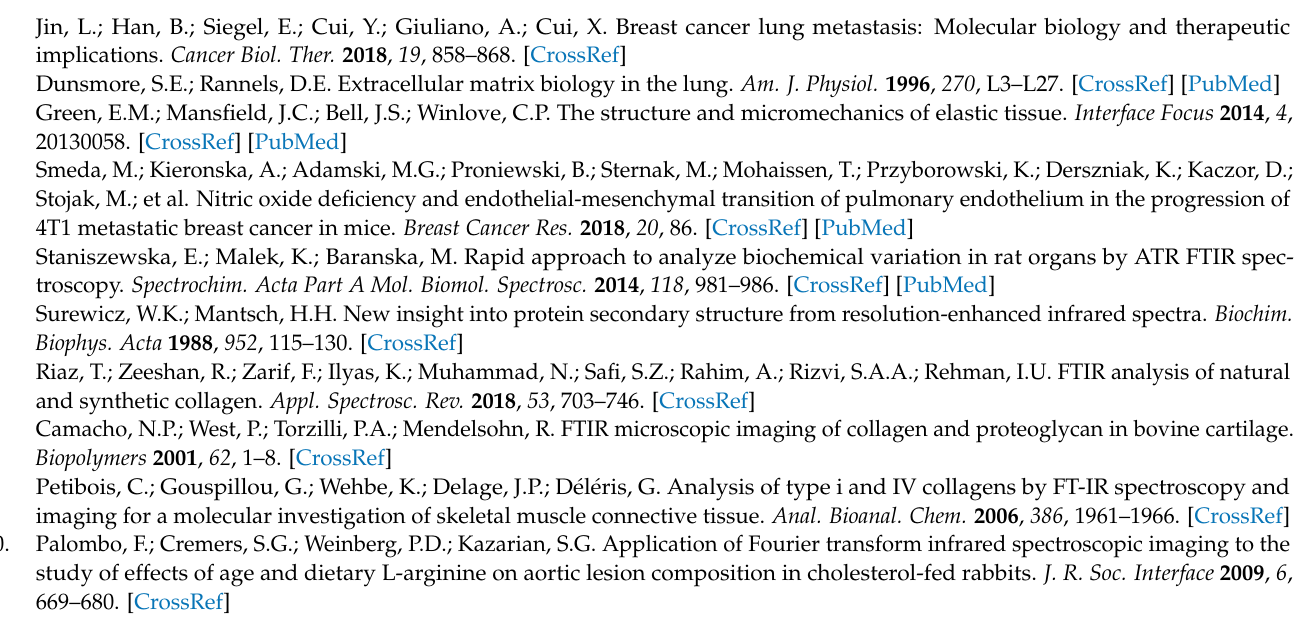
metastasis. Figure S2. Second derivative ATR FTIR spectra of pure collagen I (black), III (red), IV (blue), and elastin (green) in the regions of 900–1700 cm − 1 (A), amide I and II bands (B), amide III band (C) and stretching and deformation vibrations of the C-O, C-C and C-OH groups specific for sugar moieties (D). Figure S3. False-colour UHCA maps (A-D) of standard FTIR imaging of lung cross-sections derived from control, pre- (week 2), micro- (week 3), and macro-metastatic (week 5) phases of pulmonary metastasis of breast carcinoma. The colour of the classes corresponds to the colors mean second derivative FTIR spectra (E-L). Figure S4. Enlarged H&E micro-photography of the lung cross-section from week 5 with a marked region of solid tumor (left). The green ROI (right) was investigated with FTIR imaging (Figure